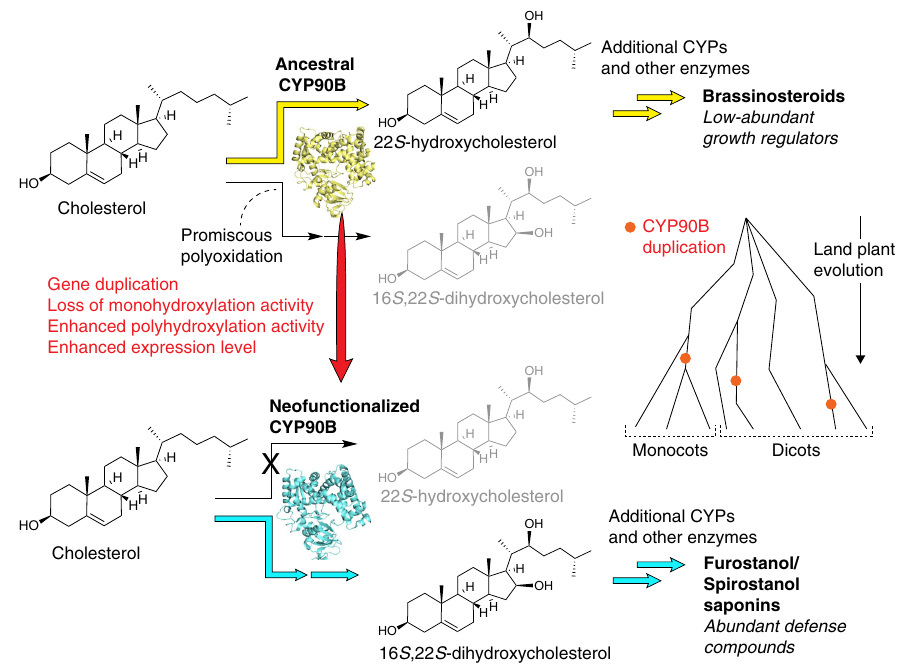
Fig. 6 Evolutionary model for occurrences of furostanol and spirostanol biosynthesis in plants. Through independent gene duplication events followed by neofunctionalization, the latent sterol 16,22-polyhydroxylase activity contained within the ancestral brassinosteroid (BR)-biosynthetic CYP90Bs was recruited to yield 16,22-polyoxygenated cholesterols, which were further derivatized by additionally recruited enzymes to establish the evolutionarily new furostanol- and spirostanol-type steroid biosynthetic systems in certain plants. Despite their evolutionary origin in phytohormone metabolism, these CYP90s exhibit a total suppression of the ancestral sterol 22-monohydroxylase activity likely owing to negative selection, which allow them to fully excise defense function without disturbing BR